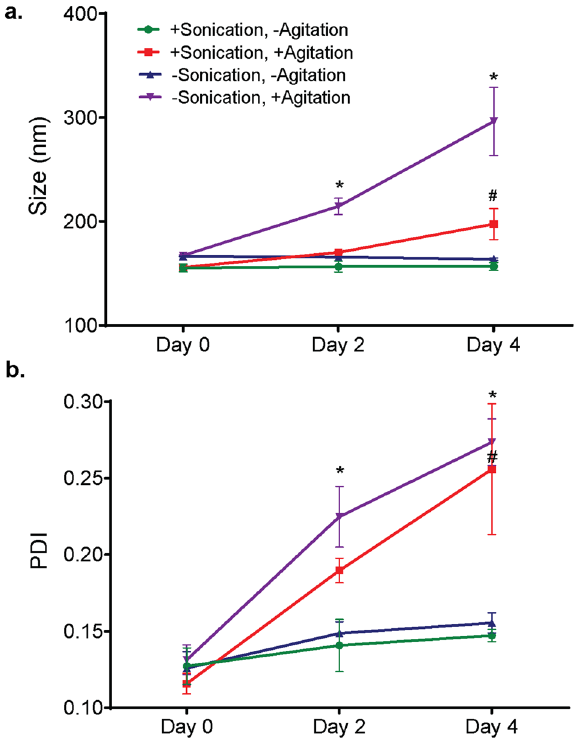
Figure 3. Effects of sonication and constant agitation on nanoparticle stability. Co-suspensions of PLGA NPs and membrane vesicles were sonicated (5 min., 15 °C, 60%) to induce membrane coating and then incubated at room temperature under static conditions (green line) or constant agitation (360° rotation at 8 rpm, red line). Control co-suspensions were not sonicated and then incubated as described above, with (purple line) or without (blue line) agitation. ( a ) Size (nm) and ( b ) polydispersity index (PDI) were assessed by dynamic light scattering on Day 0 (after sonicating), Day 2, and Day 4. Data shown are mean ± SD, n = 3. * p < 0.05, versus the other groups on the indicated day; # p < 0.05 versus Day 0. 2-way ANOVA with Tukey’s post hoc